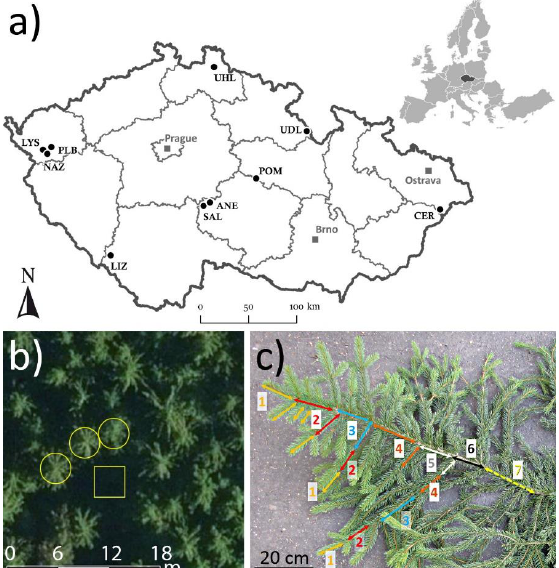
Figure 1. Study site location; soil, tree, and needle sampling design. ( a ) Location of ten GEOMON catchments under study in the Czech Republic; ( b ) design of soil and tree sampling: square—soil pit, circles—three sampled Norway spruce trees adjacent to a soil pit; ( c ) individual needle age classes (NAC) on Norway spruce branch, NAC 1 and 2 were sampled separately to represent young potosyntehtically active needles, NAC3 was not sampled, four to seven seasons old needles were pooled and labeled as NAC4 to represent older less active needles.